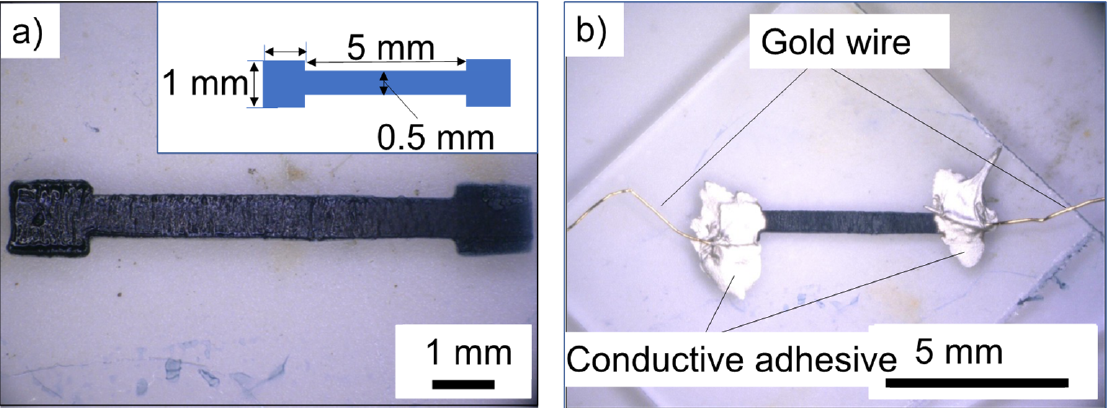
Polymers 2022 , 14 , x FOR PEER REVIEW Figure 7. Photograph of an example of fabricated wiring (inserted picture indicates model) ( a ); and gold wire with conductive adhesive to evaluate conductivity of fabricated wiring model ( b ).